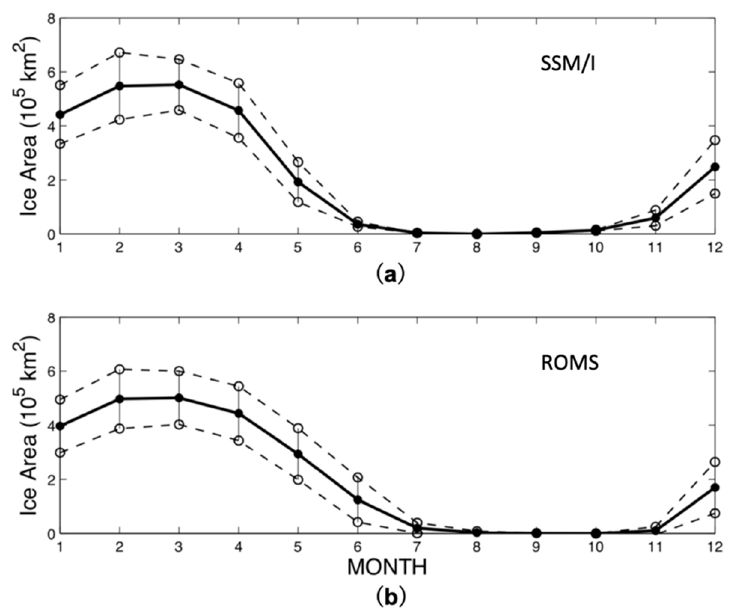
Figure 2. Seasonal variation in the sea ice covered area in the Bering Sea derived from sea-ice area concentration: ( a ) from Special Sensor Microwave/Imager (SSM/I) data with the resolution of 25 km; ( b ) from the regional oceanic modeling system (ROMS) model output data. The solid line is the monthly averaged sea-ice area for 15 years (1990–2004), and the dashed lines are the averages plus/minus one standard deviation.